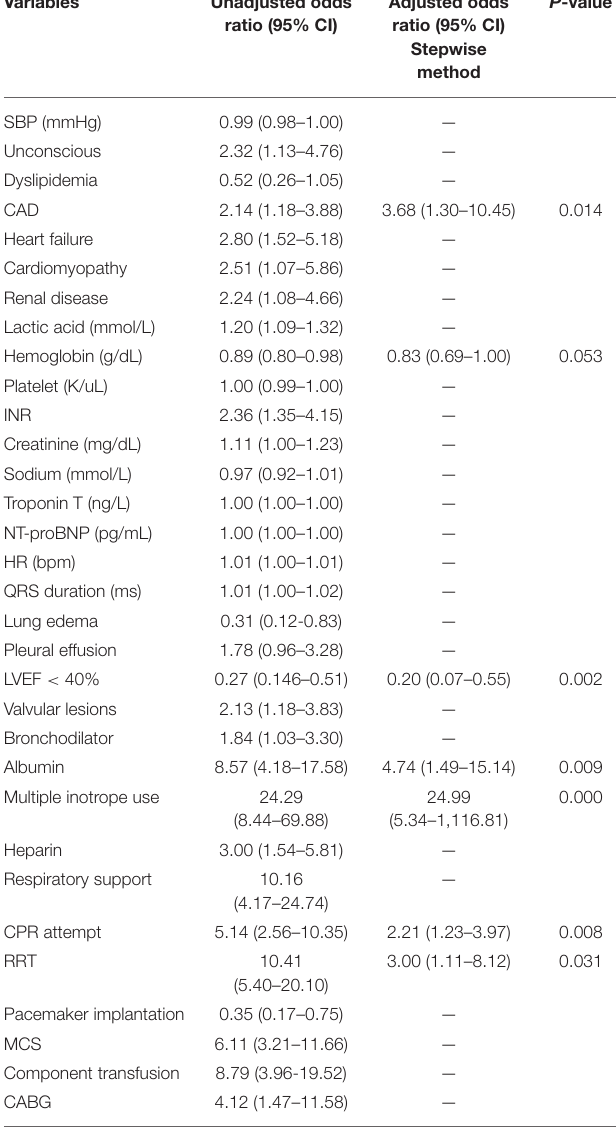
TABLE 3 | Adjusted and unadjusted odds ratios of predictive